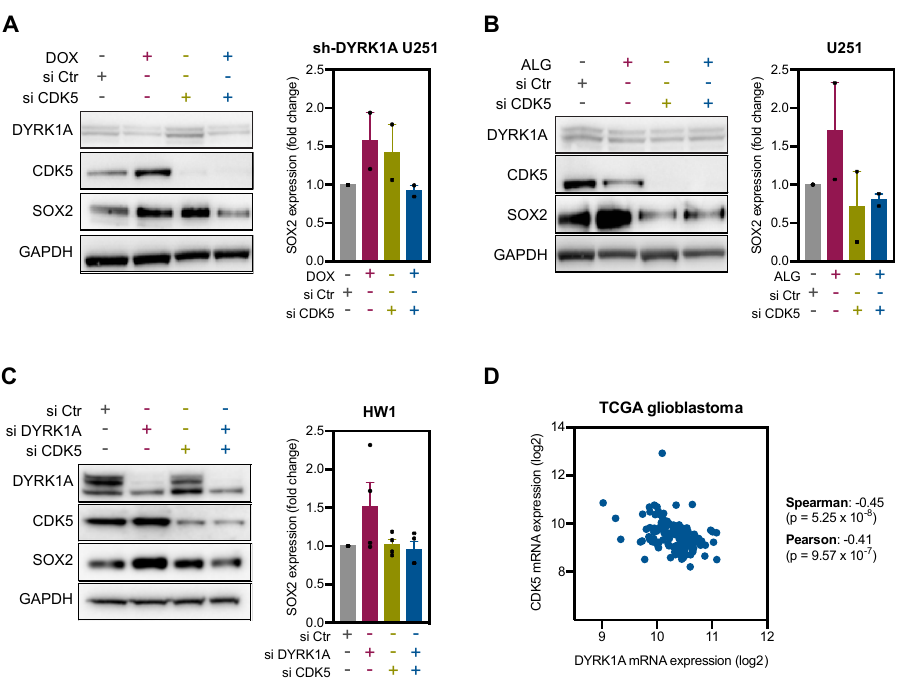
Figure 5. DYRK1A regulates SOX2 expression in glioblastoma cells via CDK5. ( A ) Immunoblots images of DYRK1A, CDK5 and SOX2 expression in U251 cells transfected with doxycycline (DOX)- inducible shRNA targeting DYRK1A (U251 sh-DYRK1A). CDK5-targeting (si CDK5) siRNA was employed to knock down CDK5 prior DOX-induced DYRK1A knockdown (72 h). Quantification of SOX2 is shown ( n = 2). ( B ) Immunoblot images of DYRK1A, CDK5 and SOX2 in U251 cells transfected with si CDK5 (24 h) and treated with DYRK1A inhibitors ALGERNON (ALG, 72 h). Quantification of SOX2 is shown ( n = 2). ( C ) Immunoblot images of DYRK1A, CDK5 and SOX2 in HW1 cells transfected with scramble (si Ctr), DYRK1A (si DYRK1A) and CDK5 (si CDK5) targeting siRNA for 72 h. Quantification of SOX2 is shown ( n = 3–4). ( D ) Correlation of DYRK1A and CDK5 expression in the TCGA glioblastoma cohort Firehose Legacy ( n = 136, www.cbioportal.org). All bar graphs represent mean ± SEM (two-tailed, unpaired t -test).